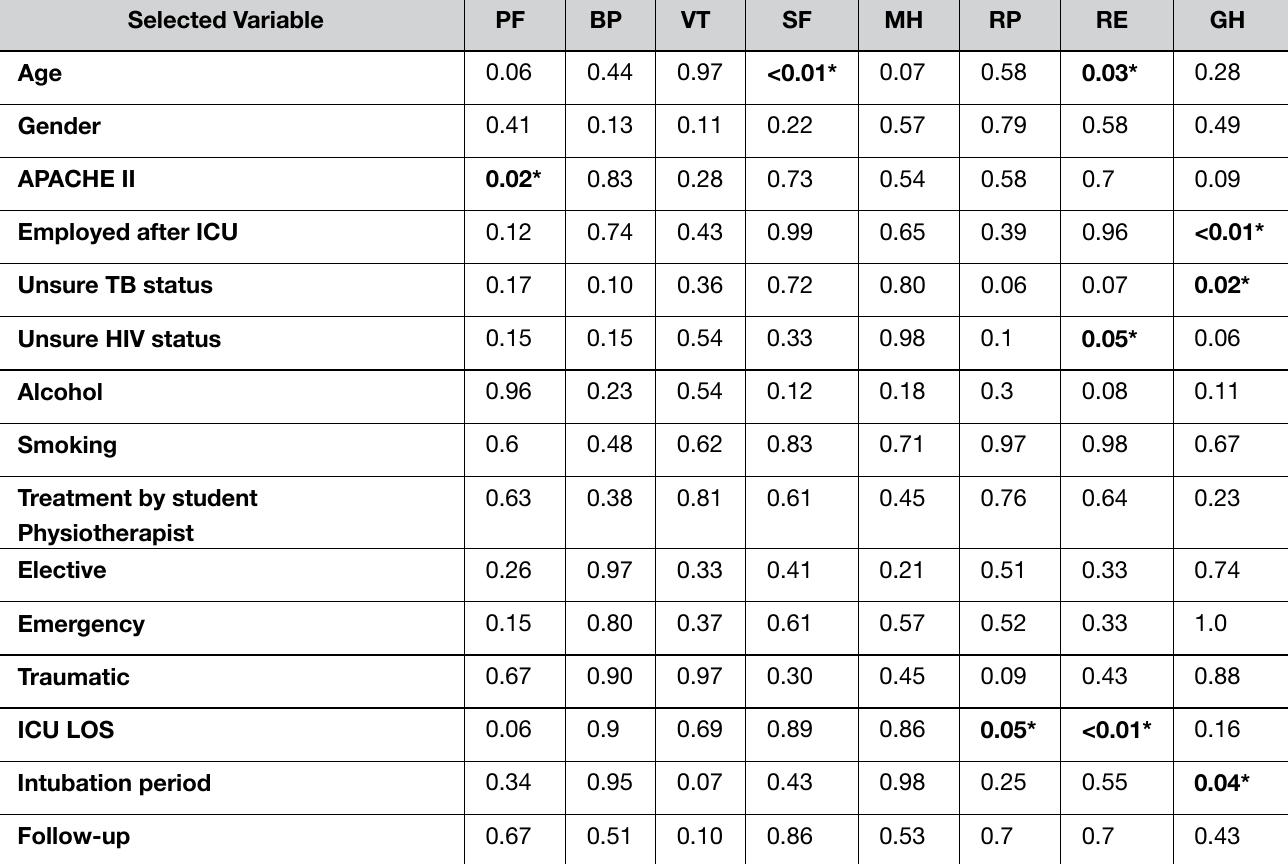
Table 3: Association between selected variables with SF-36v2 HRQoL domains (*significant p-values) Selected